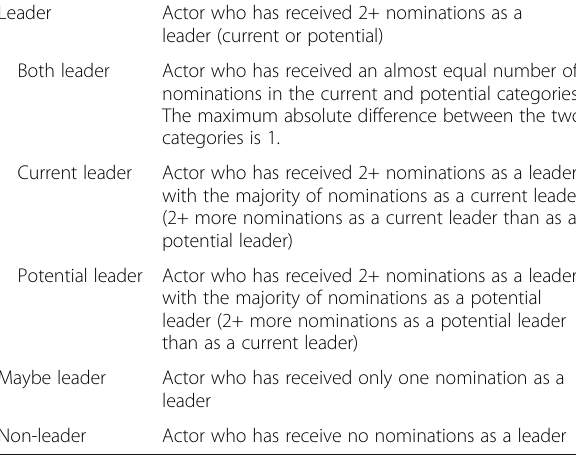
Table 2 Definitions of leadership categories